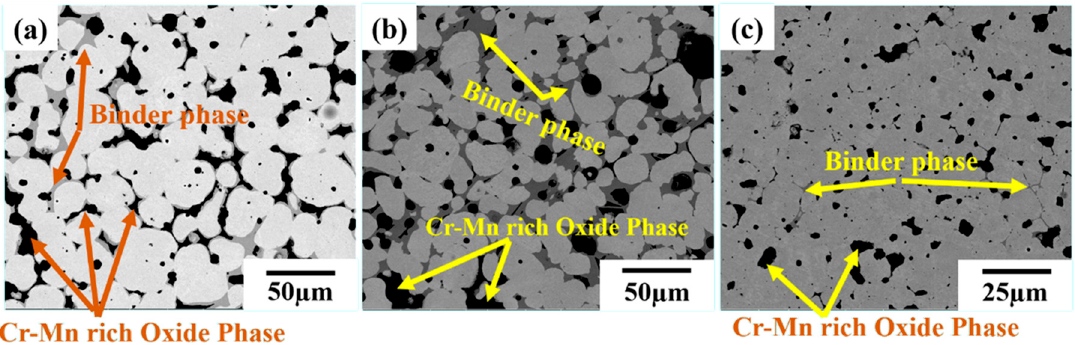
Figure 4. Scanning electron microscopy images of tungsten heavy high-entropy alloy (WHHEA) composites consolidated by ( a ) conventional sintering (CS), ( b ) microwave sintering (MWS) and ( c ) spark plasma sintering (SPS).